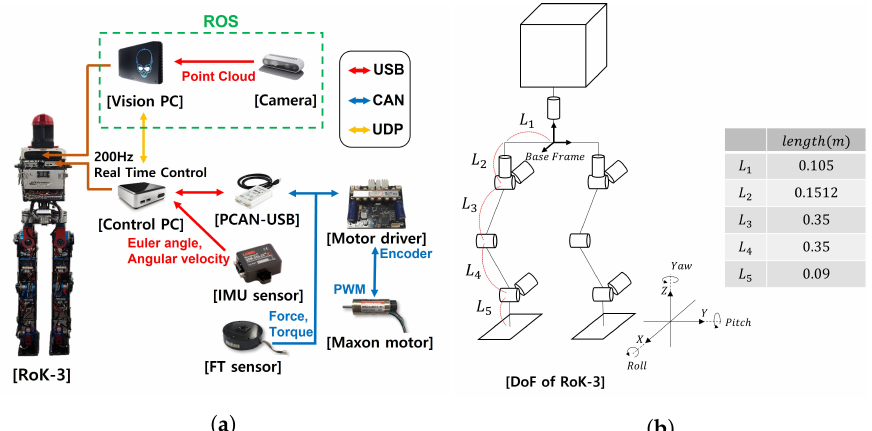
Figure 11. ( a ) The communication system about RoK-3; ( b ) Degree of Freedom about